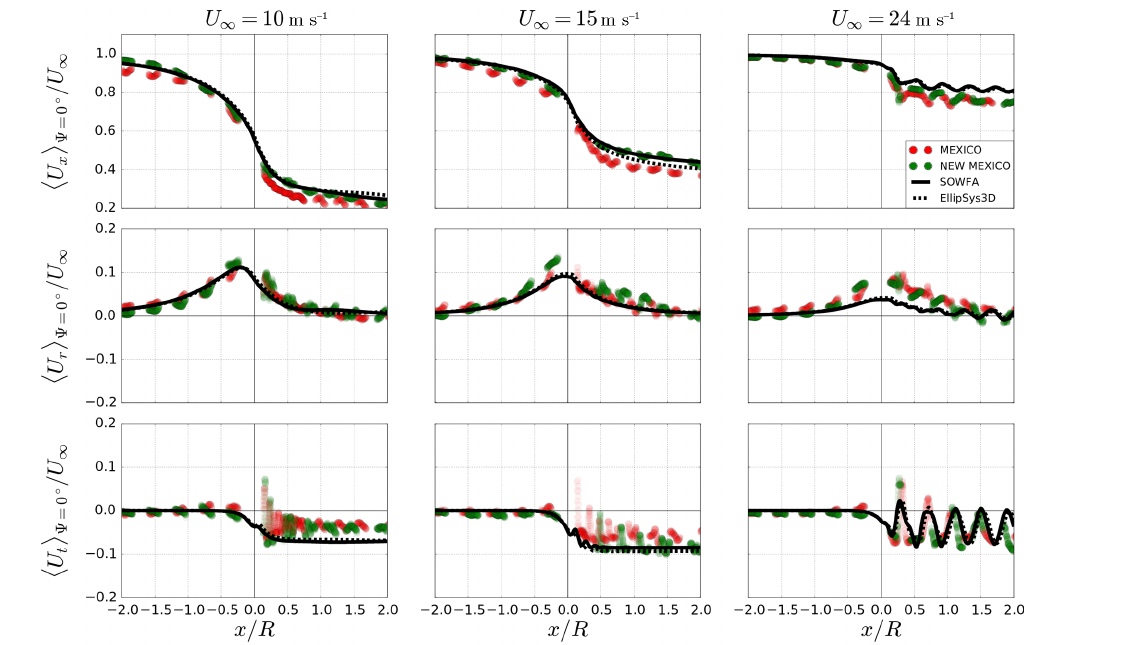
Figure 5. Axial profiles of phase-averaged (rotor position (cid:57) = 0 ◦ ) velocity components normalized by the case-specific reference velocity U ∞ . Three different flow cases for an outboard radial position are